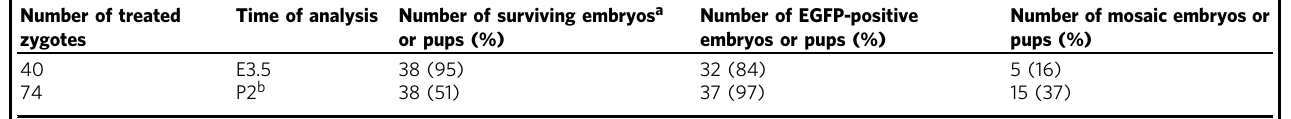
Table 3 Ex vivo Cre recombination after transduction of R26 mTmG zygotes with rAAV6- Cre Number of treated